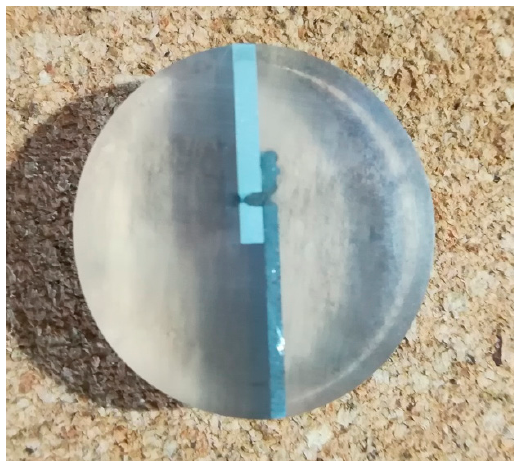
Figure 8. Solidified sample after injection of epoxy resin + hardener.